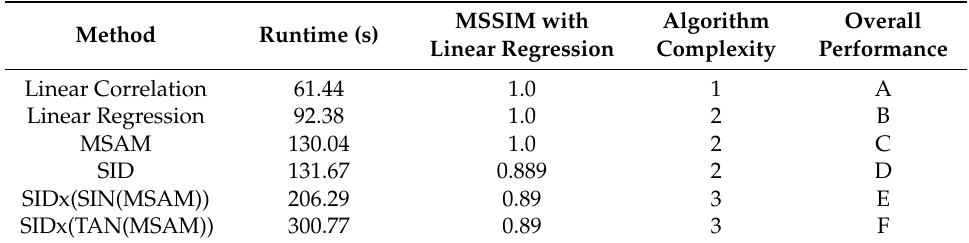
Table 1. Performance evaluation of state of the art spectral similarity measures using a 100 ˆ 100 pixel simulated EnMAP subset from Rodalquilar in an EnGeoMAP 2.0